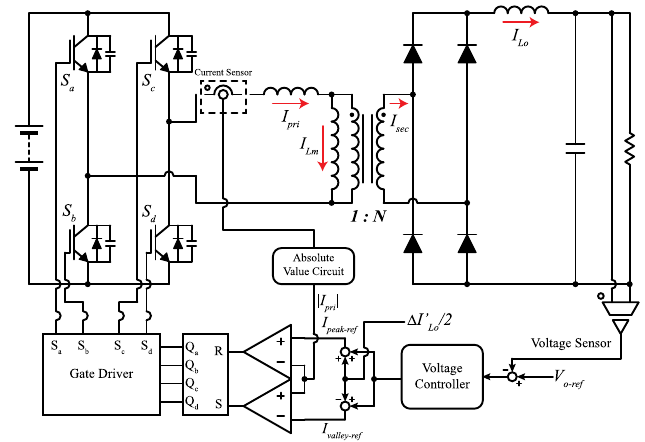
Figure 11. Circuit diagram of the proposed hybrid current-mode control (HCMC) for PSFB